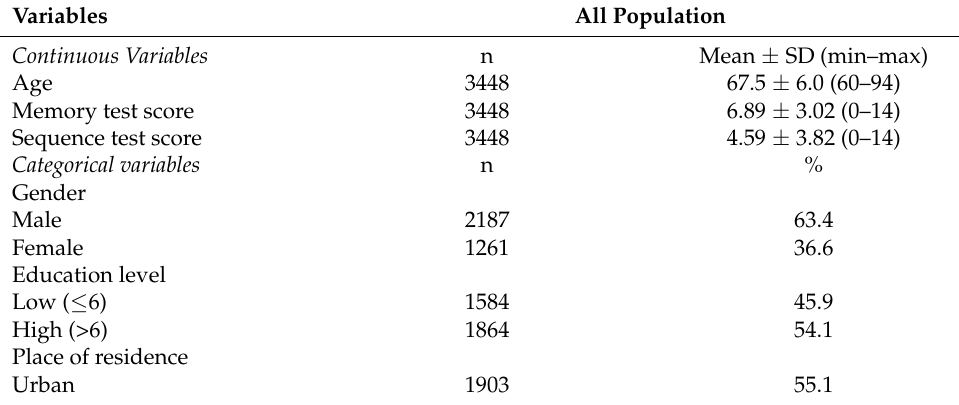
Table 1. The demographic information of all the participants.